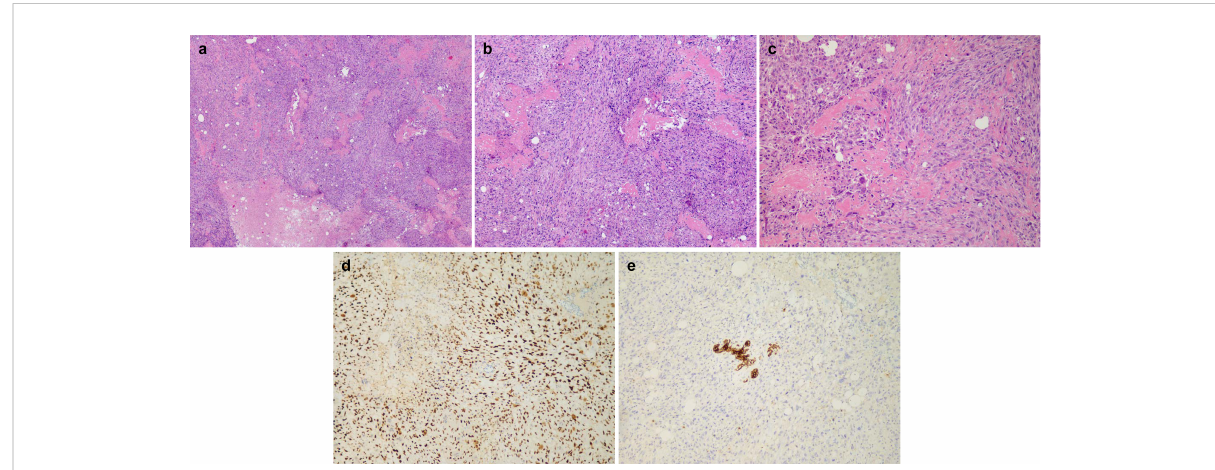
FIGURE 2 Histology: (A) ×25 magni fi cation, (B) ×50 magni fi cation, and (C) ×100 magni fi cation of H&E staining for representative osteoid matrix and necrosis. (D) Immunohistochemistry (IHC) staining of SATB in representative tumor areas. (E) IHC staining of AE1/3 in representative tumor